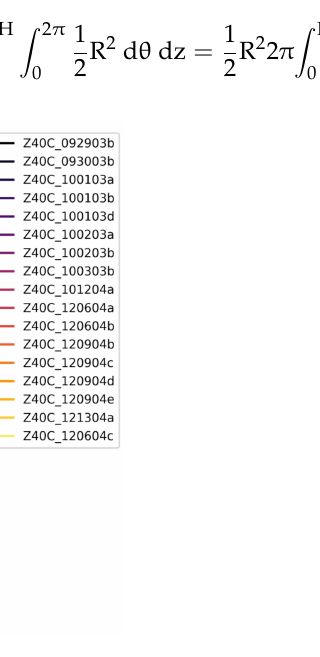
Figure 1. The triaxial stress–strain and volumetric–axial strain curves of 17 tests. Dashed intervals indicate the temporal increments of kinematic